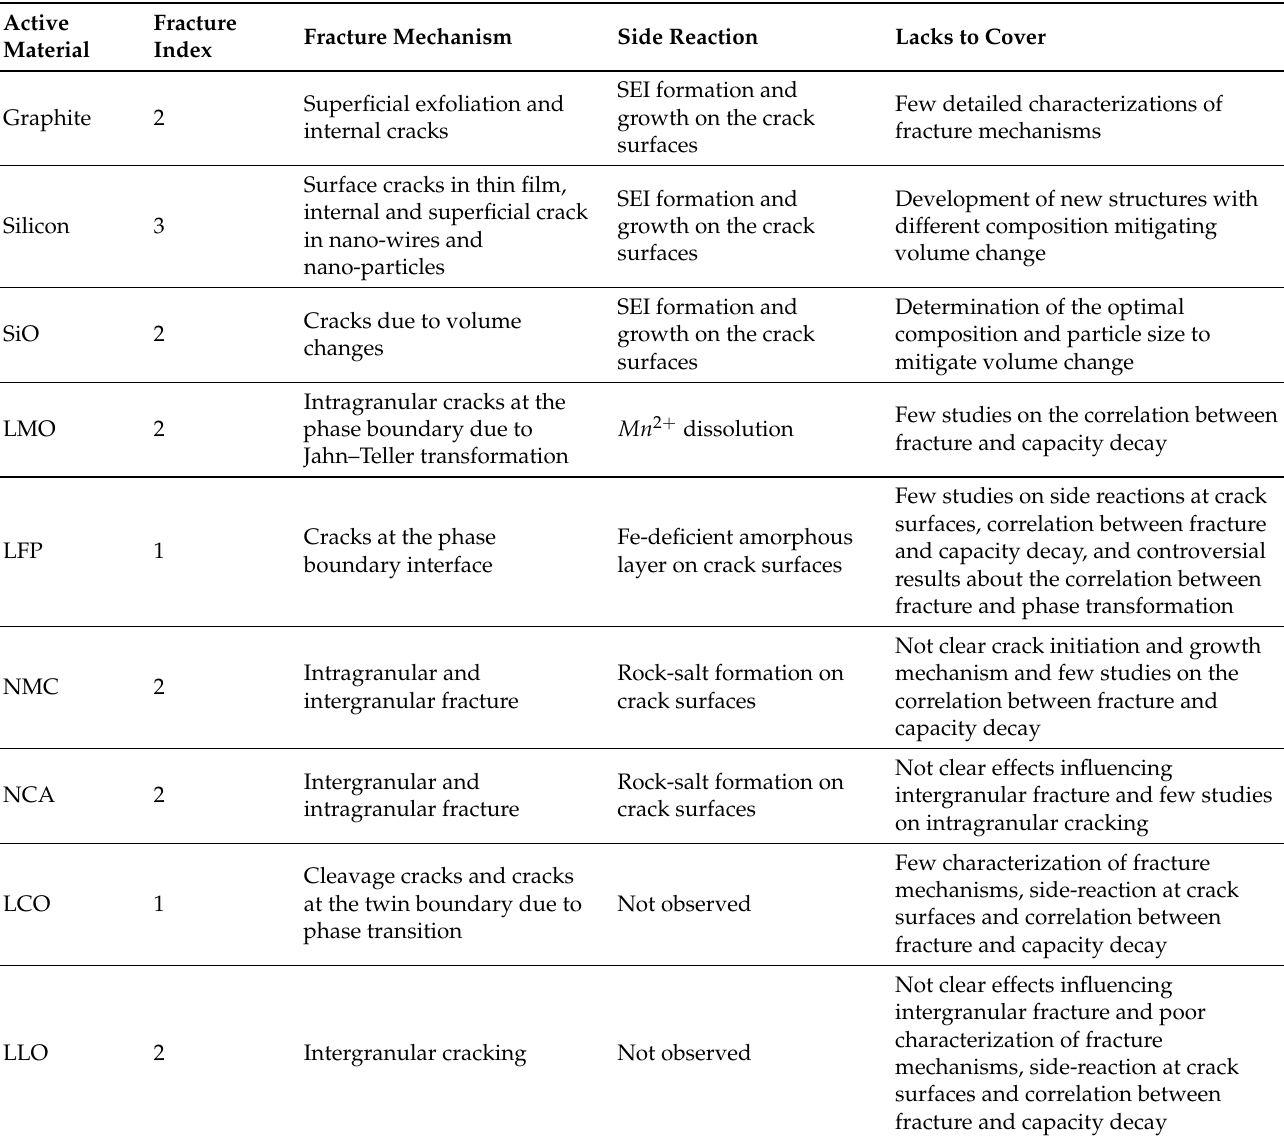
Table 2. Summary of key information for fracture in active materials revised in Section 3. The fracture index assumes the value of 1 for materials less prone to fracture, and 3 for materials which are extensively subjected to fracture during battery